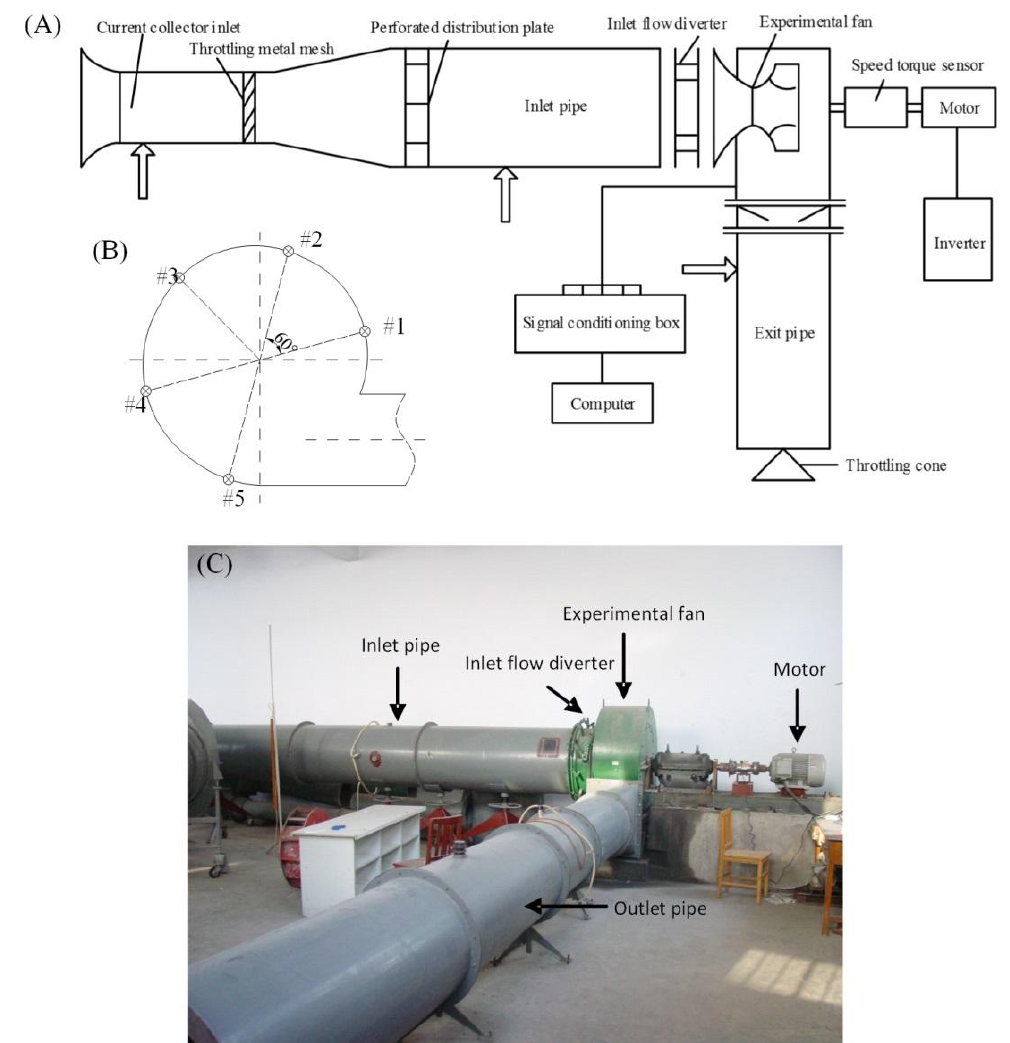
Figure 1. Experimental setup for internal pressure measurements of a centrifugal fan operated at normal conditions and under rotating